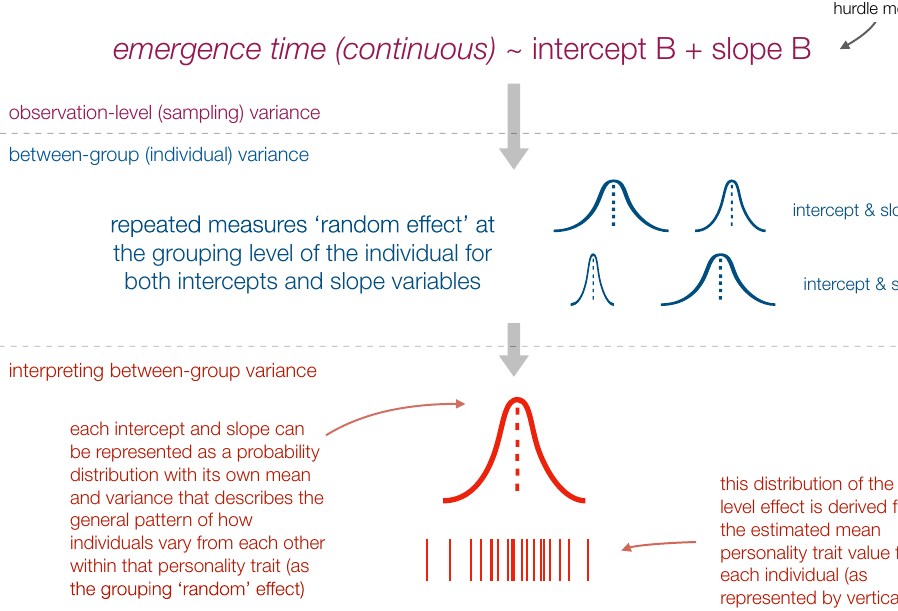
Figure 1. Schematic representation of the modelling approach used in this study to estimate the consistent individual-level differences in emergence behaviour. Observed emergence depended on a combination of a binomial and continuous process which we represented as a hurdle model: i.e. whether the individual emerged or not during the trial (binomial), and if it emerged, how long it took to leave the tube (continuous). Each of these processes was modelled as an intercept (average across all experimental trials) and a slope (change in probability or time with experience from each additional experimental trial). Because individuals were tested multiple times, these intercepts and slopes were modelled at a lower hierarchical level using the identity of each individual to estimate consistent differences between individuals. The Bayesian framework allowed us to examine these differences between individuals in two ways: (1) by extracting the posterior distributions that described the mean and range of the variation at the individual level, and (2) by directly estimating the mean for each individual’s ‘personality score’ for each of the model parameters (i.e. behavioural traits) of